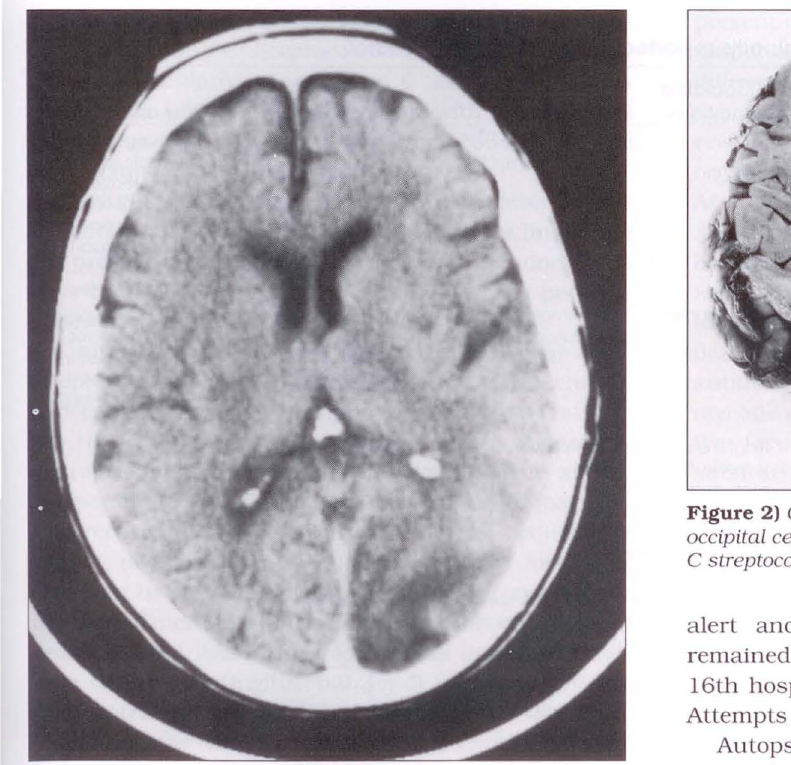
Figure 1) Computed tomographic scan after irifusion of contrast material showing a nonenhancing hypodense area in I he left parieto-occipital region in a 69-year-oldfemale presenting with shortness of breath and altered consciousness